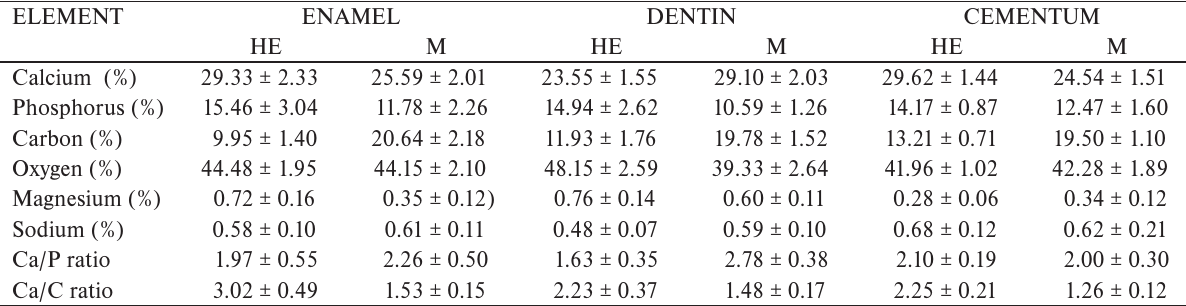
Table 1. EDS results from enamel, dentine and cementum.